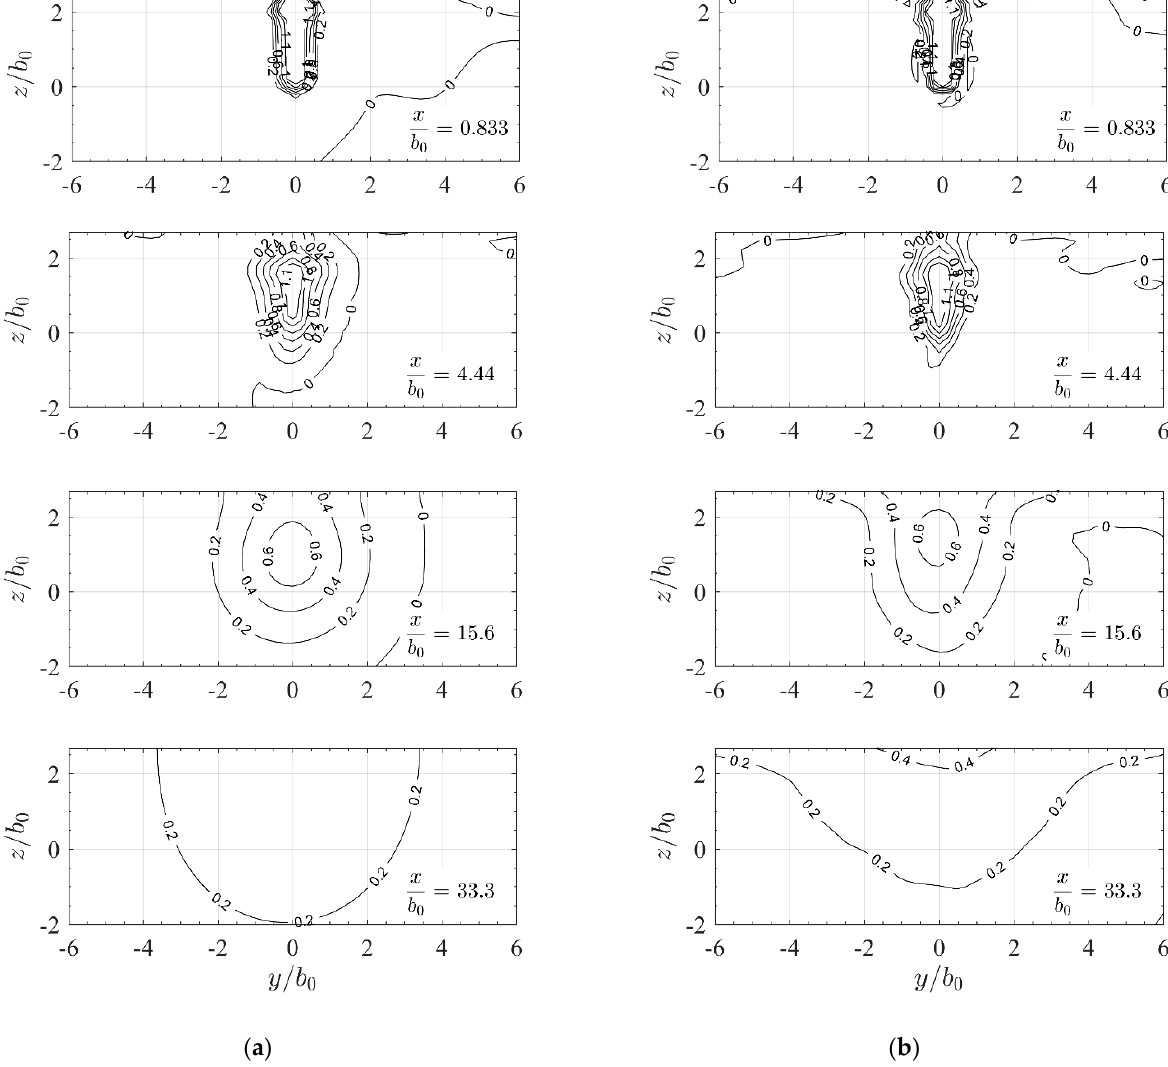
Figure 9. Slot jet with homogeneous approach flow showing isolines of the normalized streamwise velocity component u / u 0 in yz-sections with relative distances x / b 0 from the orifice as simulated for ( a ) sh-rans and ( b ) sh-des slot configuration. Distances y and z are normalized with channel/slot width b 0